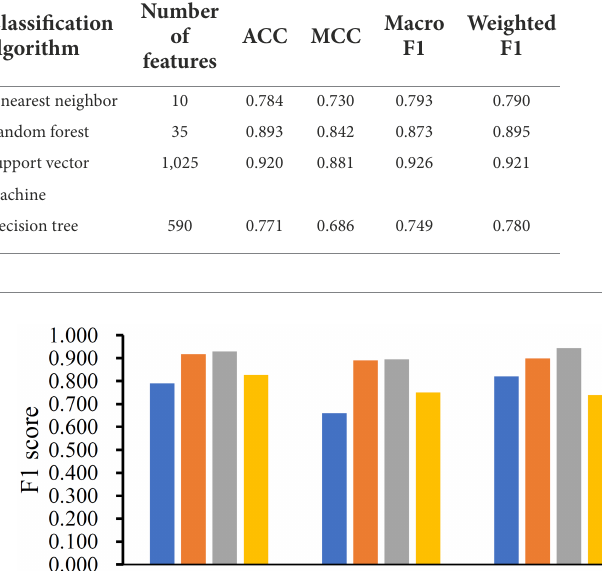
TABLE 2 Overall performance of the optimal classifiers.